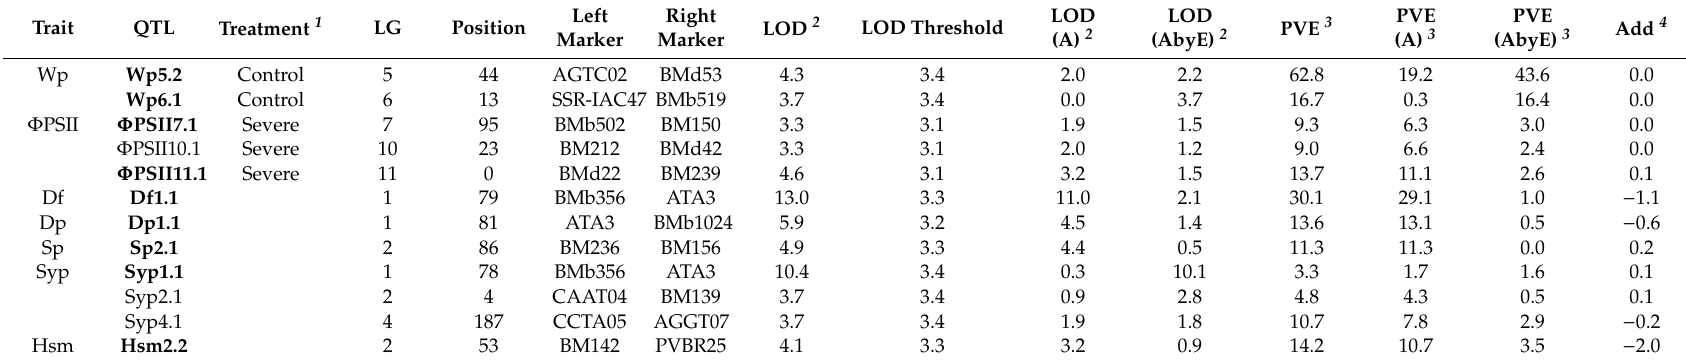
Table 2. QTL × environment interaction QTLs for leaf water potential (Wp), e ff ective quantum yield of PSII ( Φ PSII), days to flowering (Df), days to pod-setting (Dp), number of seeds per pod (Sp), seed yield per plant (Syp), and 100 seed mass (Hsm) in two seasons for drought and control for the common bean RIL mapping